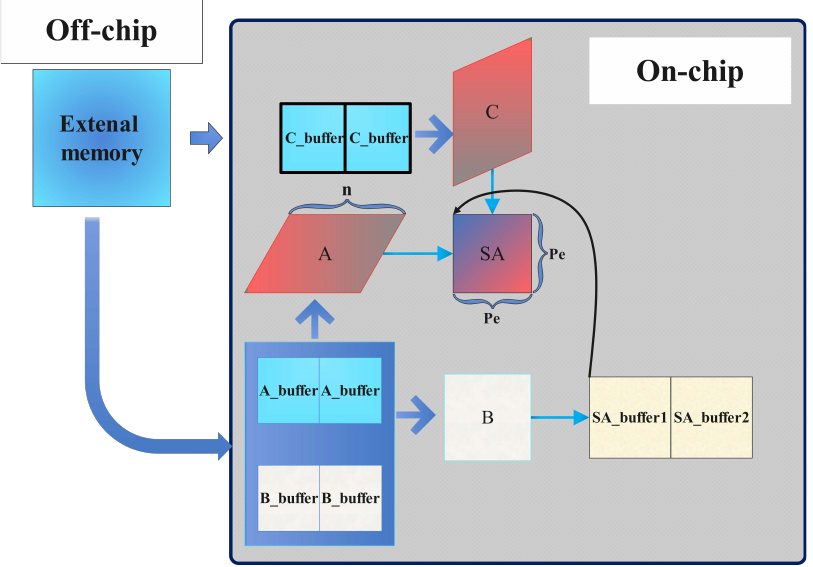
Figure 2. The 2D systolic array accelerator